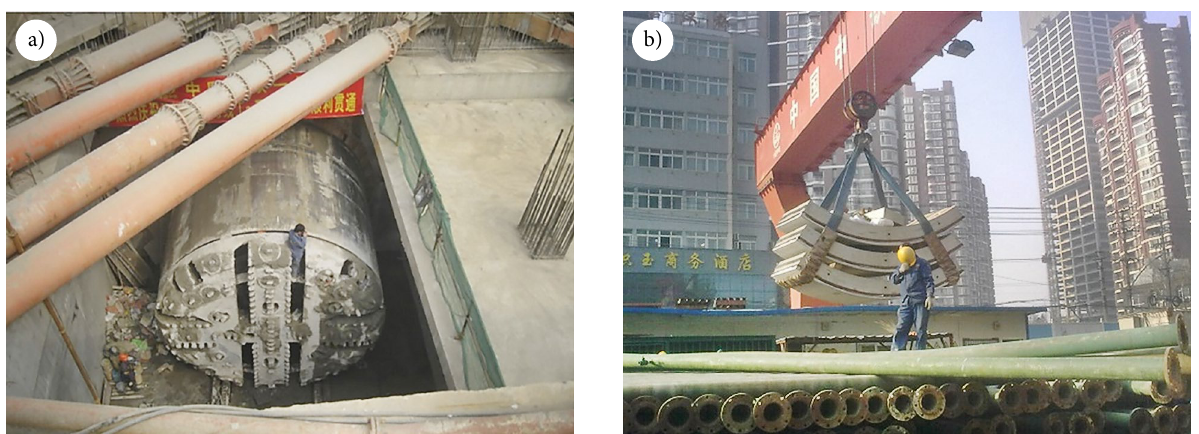
Figure 1. Behavioral risk chains: a – not wearing personal protective equipment: climbing to the top of a shield machine; b – not wearing personal protective equipment: entering into dangerous area of